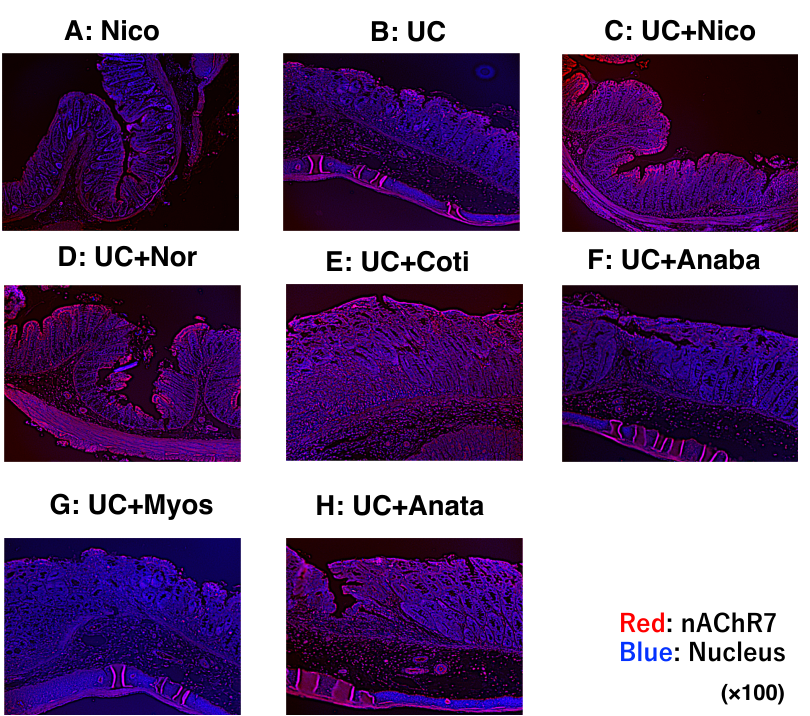
Figure 7. In-depth evaluation of nAChR7 expression in rat colonic tissues. ( A – H ) Results of FICS of nAChR (red fluorescence) in rat colonic tissues from the Nico, UC, UC + Nico, UC + Nor, UC + Coti, UC + Anaba, UC + Myos, and UC + Anata groups, respectively. DAPI-stained nuclei exhibit blue fluorescence. All microscopic images were observed using a BIOREVO BZ-9000 microscope (Keyence Co., Ltd., Osaka, Japan). High-power magnification was used for all panels ( × 200). Anaba, anabasine; Anata, anatabine; Coti, cotinine; FICS, fluorescent immunochemical staining; Myos, myosmine; nAChR7, α 7 nicotine acetylcholine receptor; Nico, nicotine; Nor, nornicotine; and UC, ulcerative